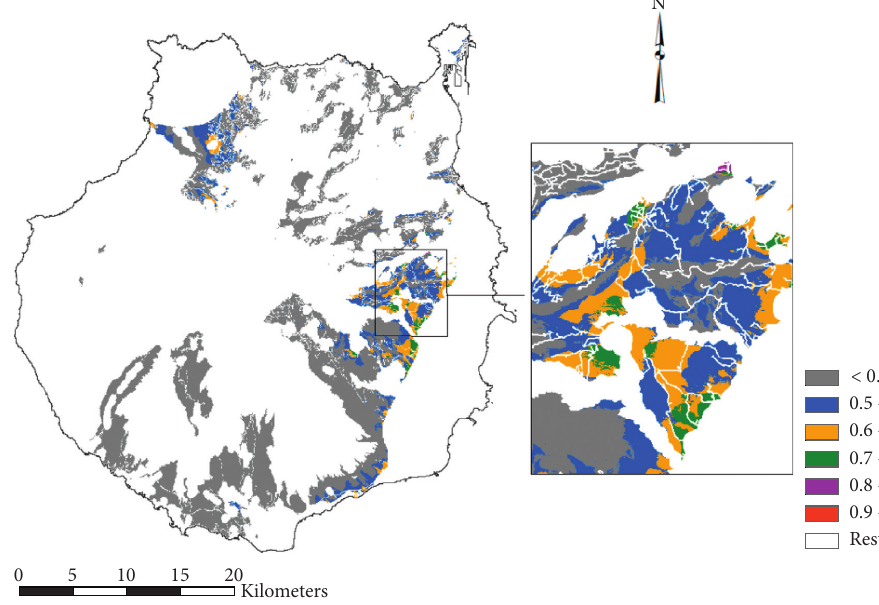
Figure 9: Wind suitability map.